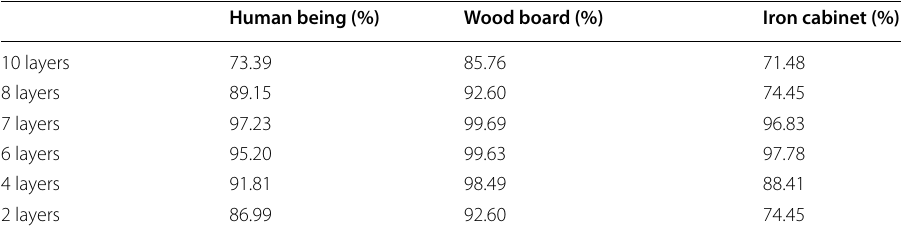
Table 1 Classification accuracy (%) of different number of layers Human being (%) Wood board (%) Iron cabinet (%) 10 layers 73.39 85.76 71.48 8 layers 89.15 92.60 74.45 7 layers 97.23 99.69 96.83 6 layers 95.20 99.63 97.78 4 layers 91.81 98.49 88.41 2 layers 86.99 92.60